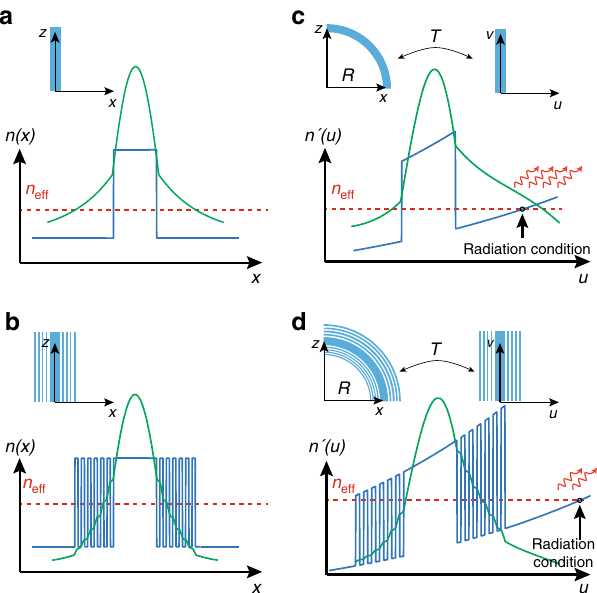
Fig. 5 Curved waveguides and skin-depth engineering. a , b Refractive index pro fi le (blue) and the magnetic fi eld pro fi le (green) of a a straight strip waveguide and b a straight e-skid waveguide. c The corresponding bent waveguides c , d can be transformed to straight waveguides with inhomogeneous refractive index pro fi les in a new coordinate system. If the local refractive index of the cladding exceeds the effective modal index (cid:3) (cid:4) n ′ ð u Þ > n , the waveguide mode starts radiating. This occurs at the 0 e ff radiation condition point denoted by black arrows. The multilayer metamaterial cladding in e-skid waveguides suppresses the evanescent wave fi eld beyond this radiation condition point. Thus, in comparison with conventional bent waveguides, lesser power is radiated owing to